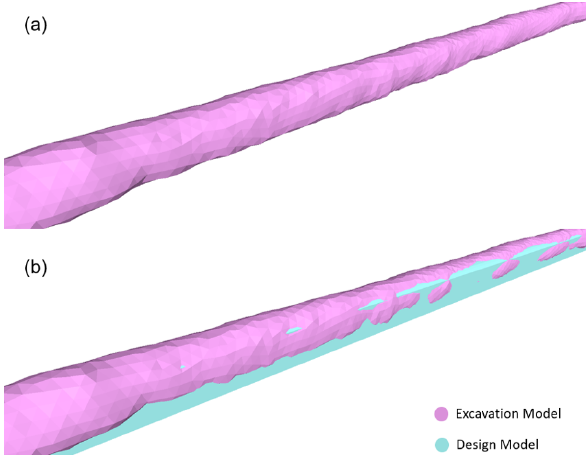
Figure 4. The reconstructed excavation model and the design model. (a) The reconstructed 3D excavation model; (b) the excavation model overlaid on the design